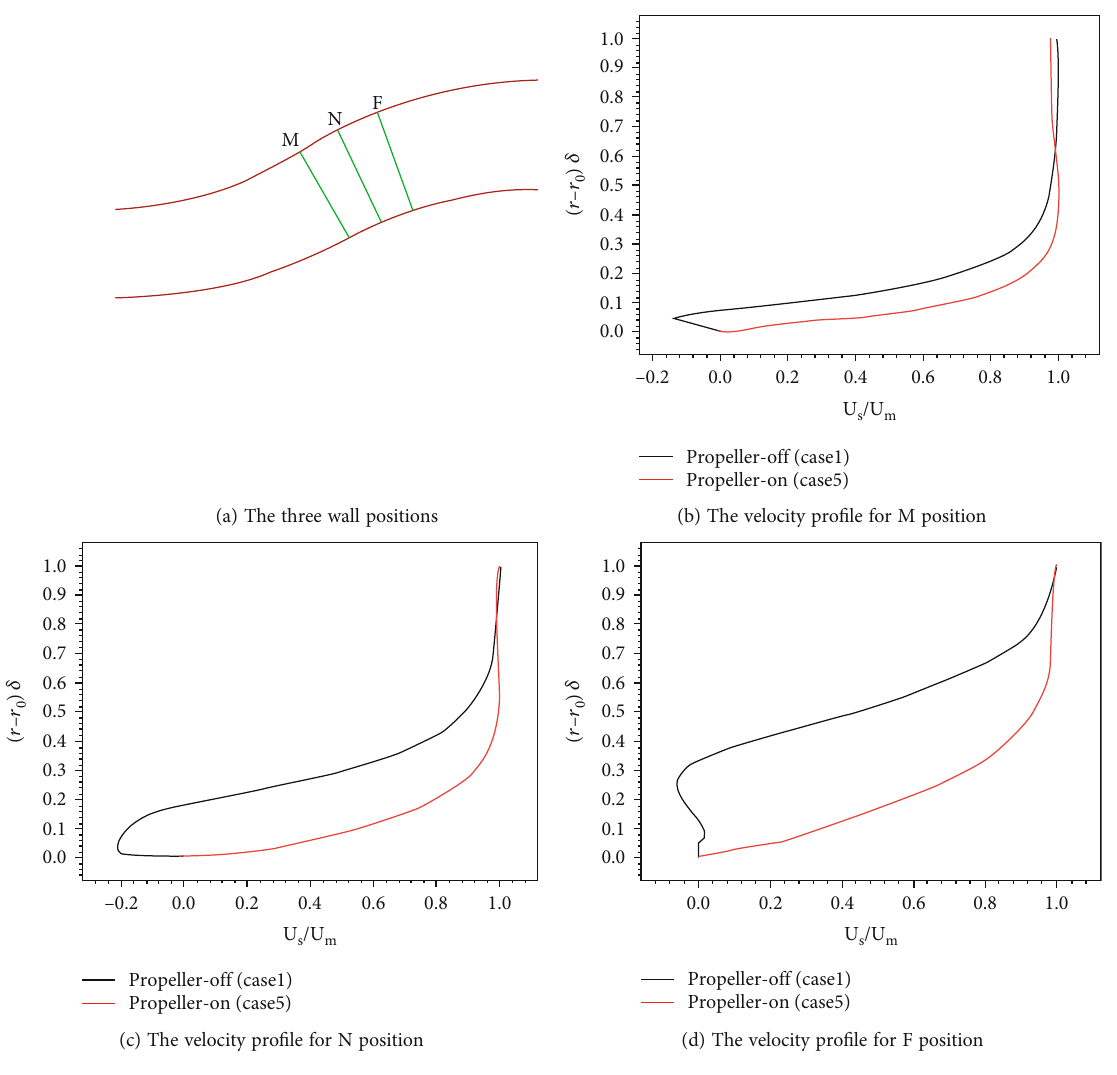
Figure 10: Velocity pro fi le for di ff erent